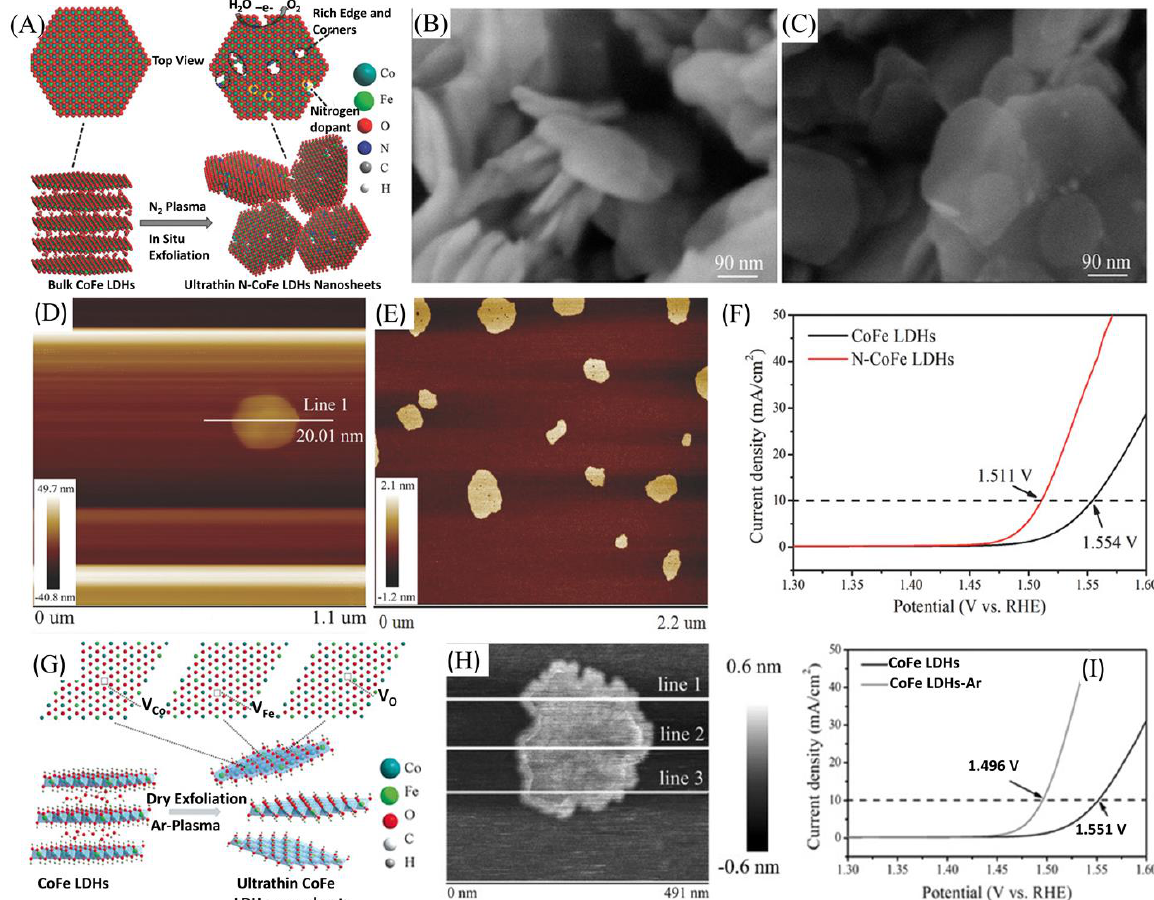
Figure 5. ( A ) Illustration of the exfoliation process of bulk CoFe LDHs into ultrathin CoFe LDH nanosheets by N plasma. ( B ) Scanning electron microscope (SEM) image of bulk CoFe LDHs. ( C ) SEM image of ultrathin N-CoFe LDH nanosheets. ( D ) Atomic force microscopy (AFM) image of bulk CoFe LDHs. ( E ) AFM image of ultrathin N-CoFe LDH nanosheets. ( F ) Linear sweep voltammetry (LSV) polarization curves of bulk CoFe LDHs and ultrathin N-CoFe LDHs nanosheets at a scan rate of 5 mV s −1 . Reproduced with permission from [71]. WILEY-VCH Verlag GmbH & Co. KGaA, Weinheim, 2017. ( G ) Schematic illustration of exfoliation of CoFe LDH nanosheets by Ar-plasma. ( H ) AFM image of ultrathin CoFe LDHs-Ar nanosheets. ( I ) LSV curves for the OER at a scan rate of 5 mV s −1 . Reproduced with permission from [69]. WILEY-VCH Verlag GmbH & Co. KGaA, Weinheim, 2017. Table 1. Comparison of OER activities of exfoliated TM-LDHs (η is at 10 mA cm −2 ). Catalyst Exfoliation Method